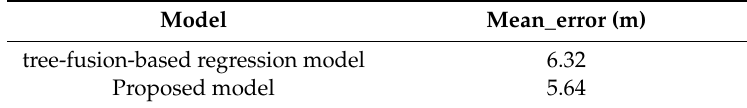
Figure 22. The positioning errors (CDF) between the proposed algorithm and the tree-fusion-based regression model.